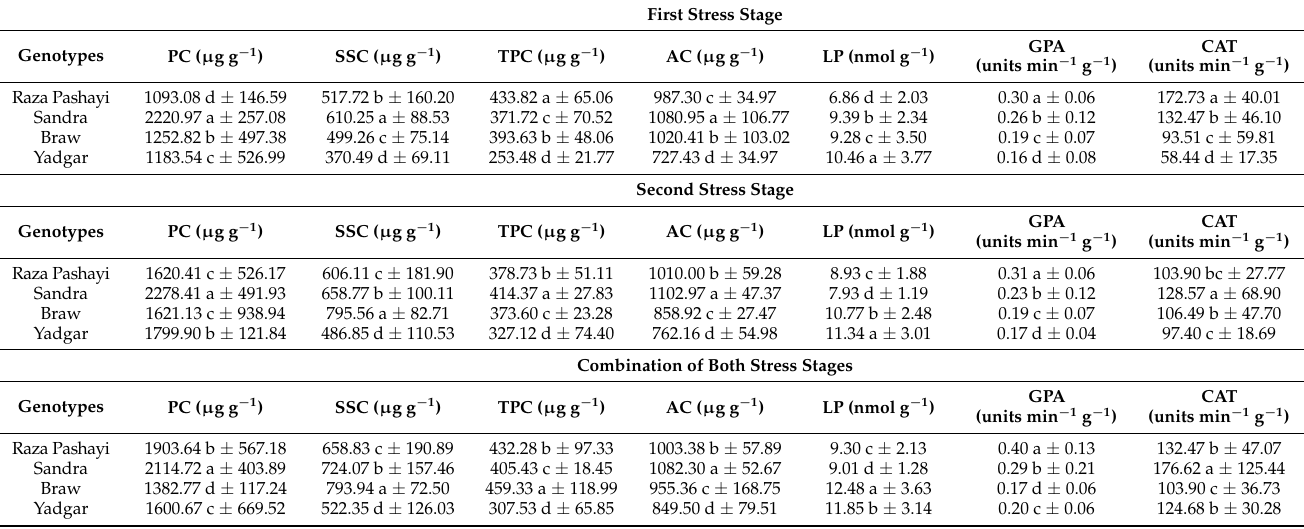
Table 6. Effects of oak leaf powder, oak leaf extract, and biofertilizer on the biochemical traits of the leaves of tomato plants under different levels of stress.